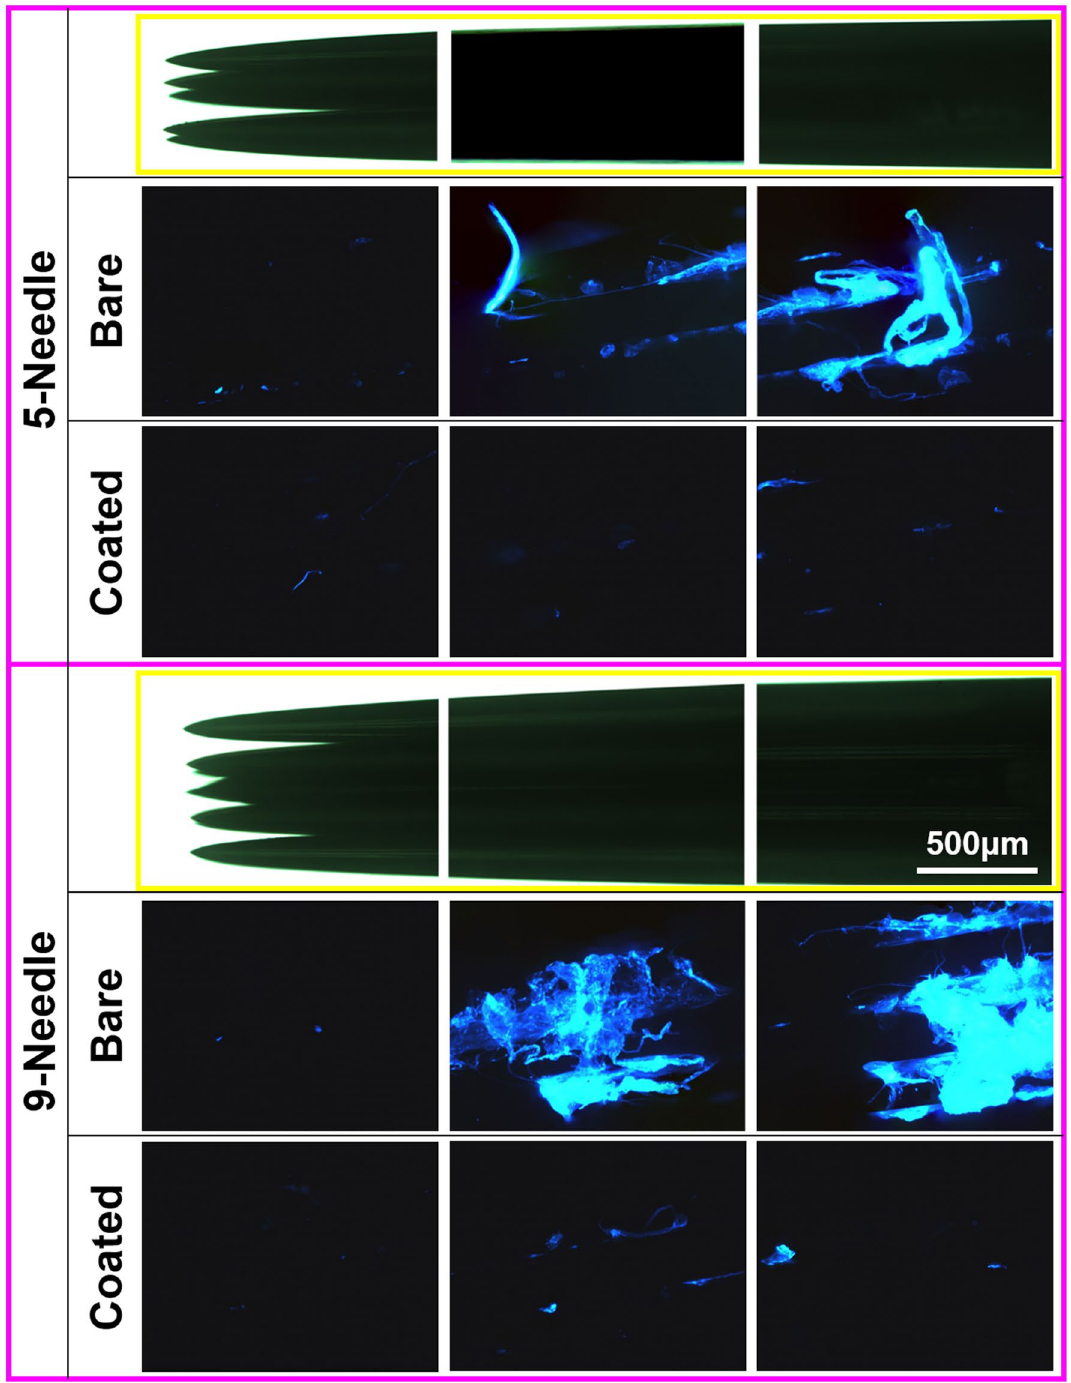
Figure 6. Fluorescent microscope images showing the area of cell remaining after 30-time insertion of bare and coated needles test on the pork skin. To facilitate the visual comparison, optical microscope images of needle parts selected for fluorescent observation are framed in yellow